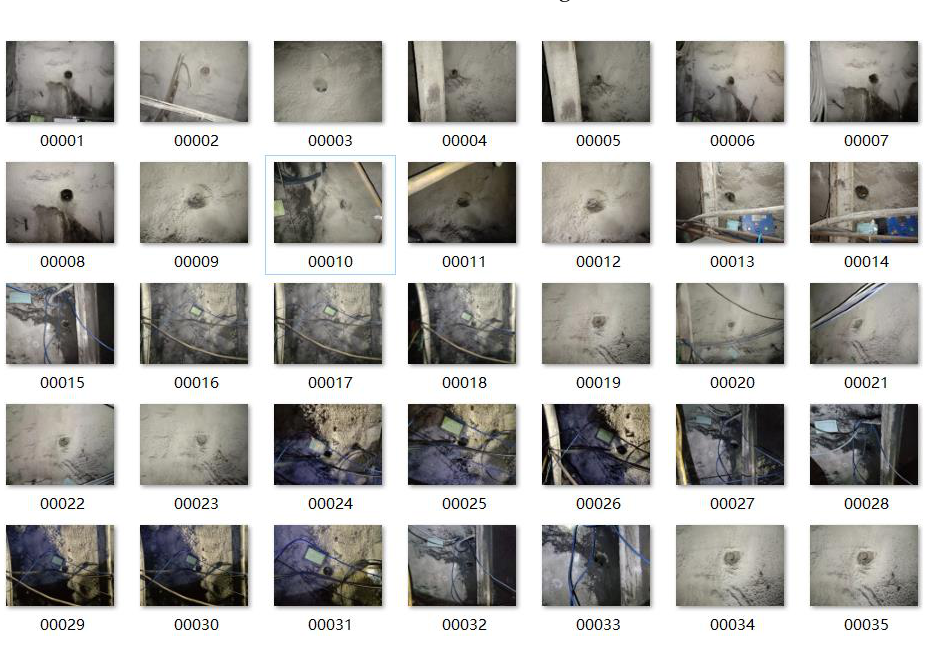
Figure 16. Partial pressure relief hole images in coal mine.